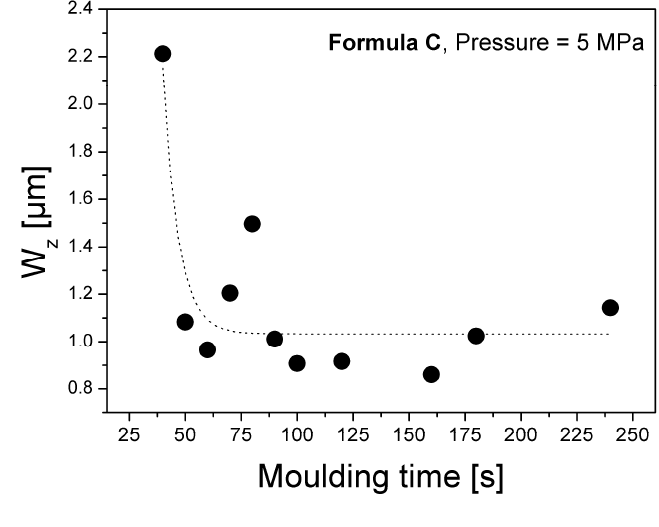
Figure 20. Decrease of short waviness by moulding time.